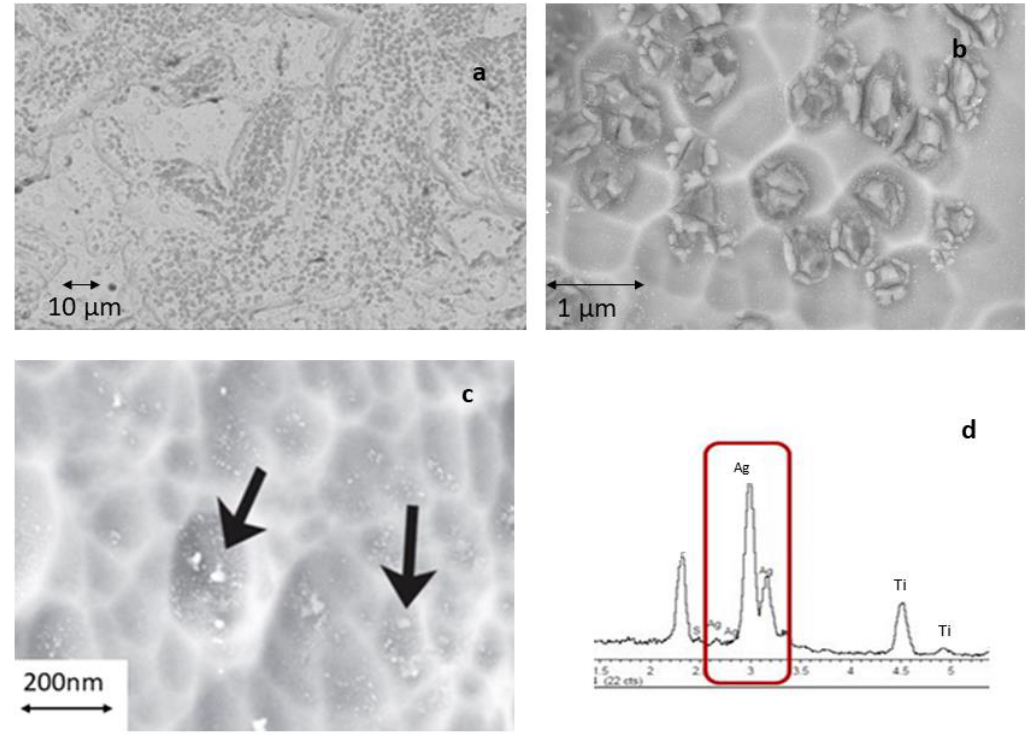
Figure 3. ( a ) Silver nanoparticles on metallic surface, ( b ) silver nanoparticles at greater magnification. The agglomeration in clusters can be seen in ( a ) and ( b ). ( c ) Silver nanoparticles on the bacteria. ( d ) EDS microanalysis of silver nanoparticle.